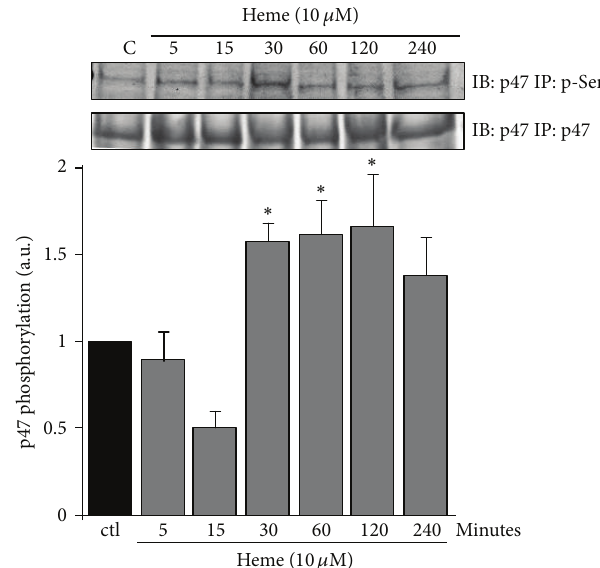
Figure 2: Heme induces p 47 phox phosphorylation in AM. Rat AMs (3 × 10 6 /mL) were cultured in the absence or presence of heme (10 𝜇 M) for different periods of time. Incubations were terminated by the addition of lysis buffer, and lysates were subjected to immunoprecipitation of p 47 phox and immunoblots with an anti- p 47 phox and p-serine antibodies were performed. The data shown are representative of three independent experiments. The mean ± S.D. is presented. ∗ 𝑃 < 0.05 when compared with